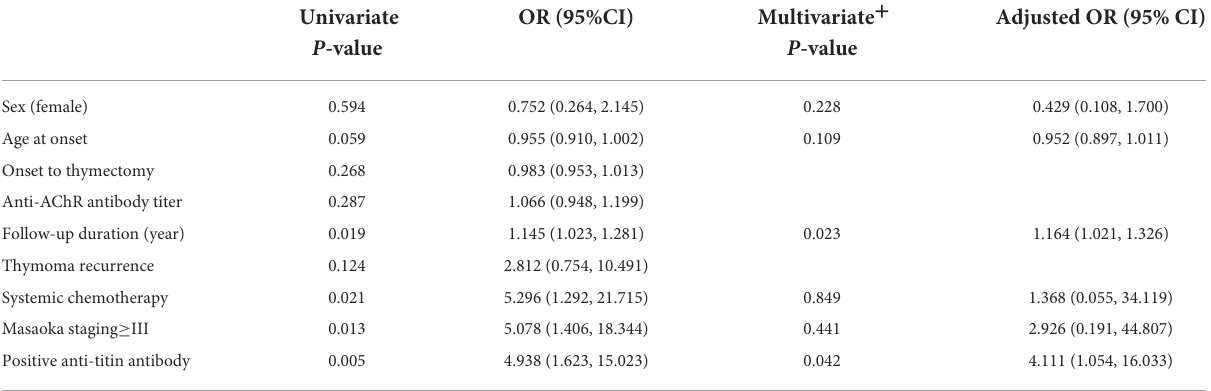
TABLE 3 Clinical variables associated with ≥ 2 times of MG-related hospitalization or ER